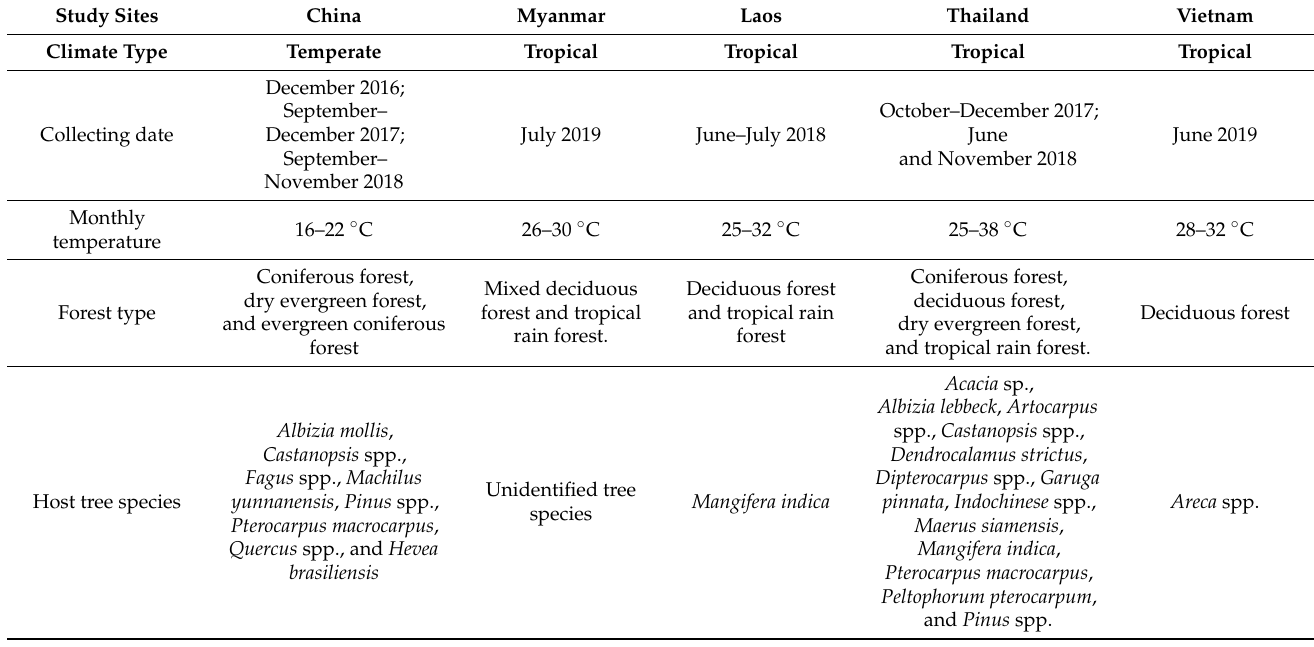
Table 2. Regional information for collection sites in the Greater Mekong Subregion, where collections